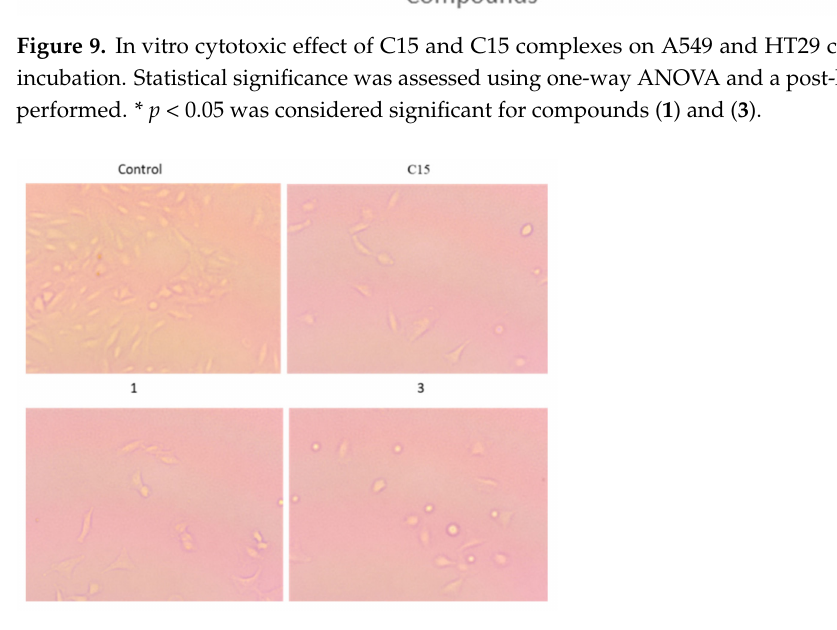
Figure 10. Effect of compounds C15, ( 1 ) and ( 3 ) on A549 cell growth. A549 cells were cultured. In the presence or absence (control) of compound. Representative phase-contrast cell images are shown after 24 h in 100 ×